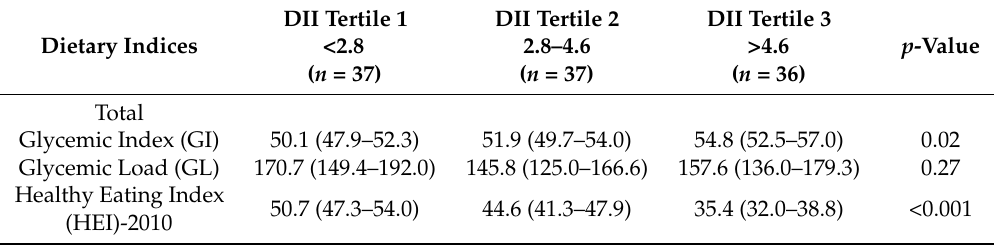
Table 3. Healthy eating index (HEI)-2010, Glycemic index, and Glycemic load by DII